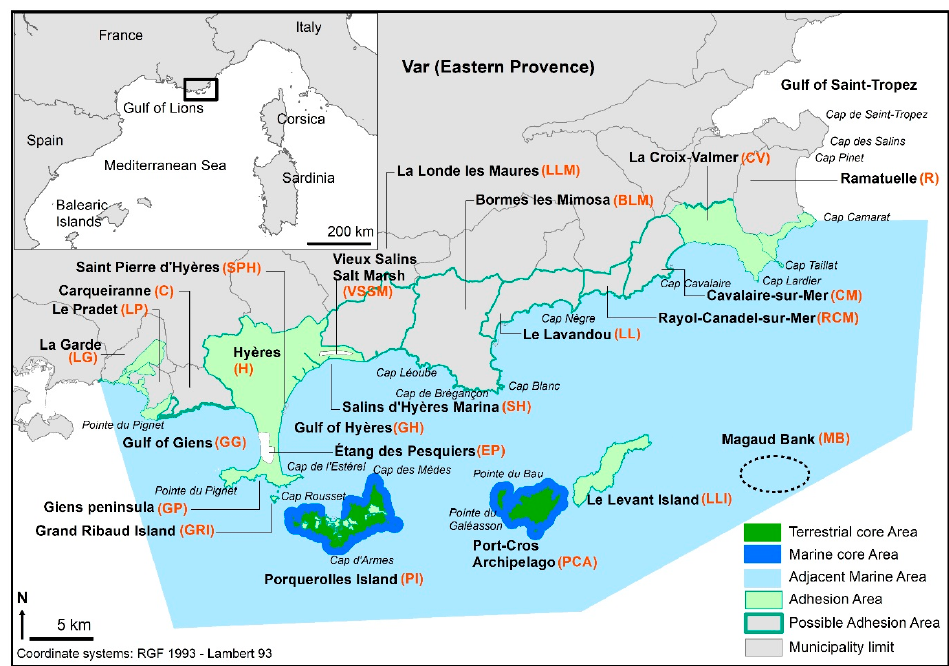
Figure 1. The new Port-Cros National Park (N-PNPC), with terrestrial and marine core areas, the adjacent marine area, the adhesion Area and the abbreviations used (in orange) for the localities and sites taken into consideration.